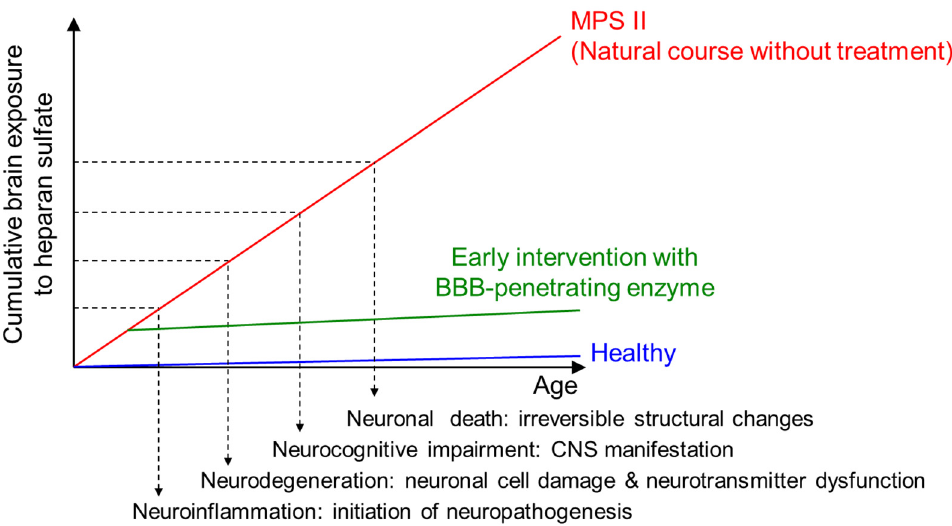
Figure 10. Conceptual association between cumulative exposure of the brain to HS and CNS disease progression in patients with neuronopathic MPS II. The vertical dashed arrows indicate the presumed timings of the onset of neuronopathic events. The Y-intercepts with dashed lines indicate the postulated levels of cumulative exposure of the brain to HS when a corresponding neuropathology evolves. The red and blue lines indicate the cumulative exposures to HS in patients with MPS II and healthy subjects, respectively. Early intervention with pabinafusp alfa decreases the intracerebral HS concentrations and thereby reduces the cumulative exposure, preventing or delaying the onset of CNS involvement. Even if the treatment starts when some symptoms have already developed, the clearance of HS accumulations in the brain may be able to reverse the symptoms by correcting neuronal dysfunctions before irreversible (mostly structural) CNS damage occurs (updated from [21]).